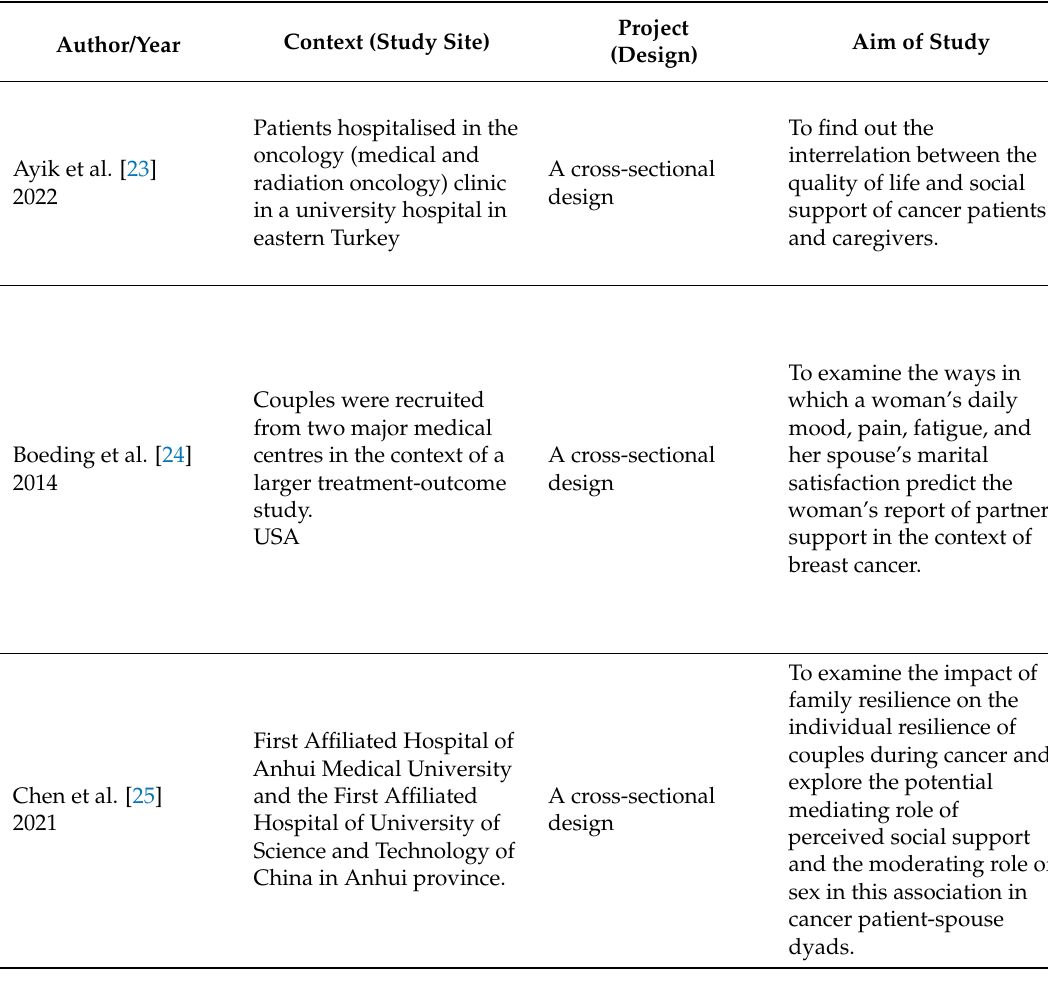
Table 1. Summary of included